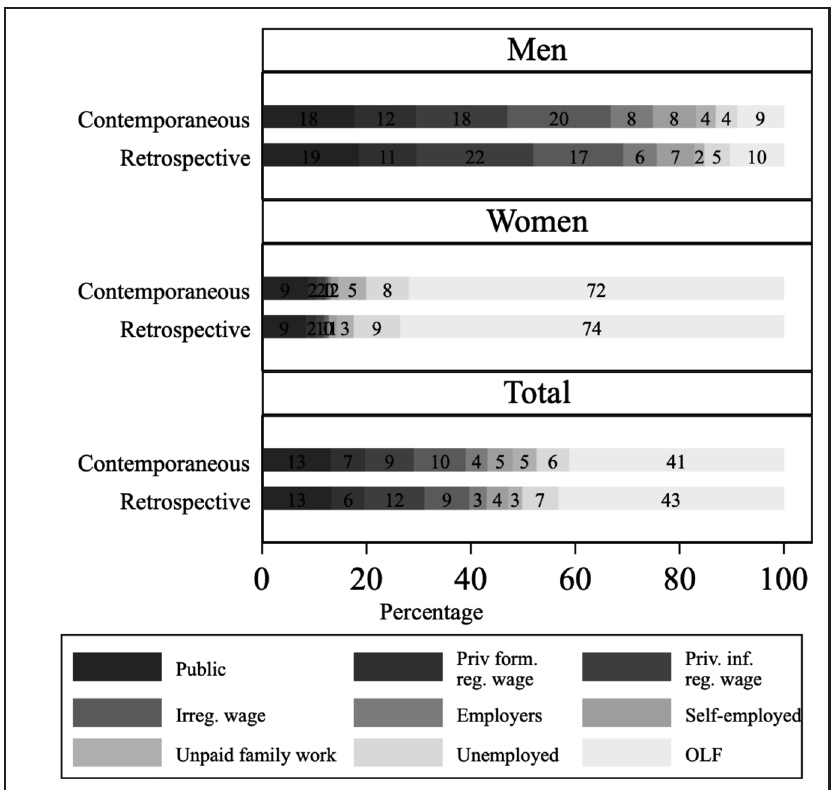
Figure 2 Labor market status, as reported contemporaneously for 2012 and as reported retrospectively for 2012 from 2018 data, by sex, individuals aged 20–44 years in 2012 and present in both waves